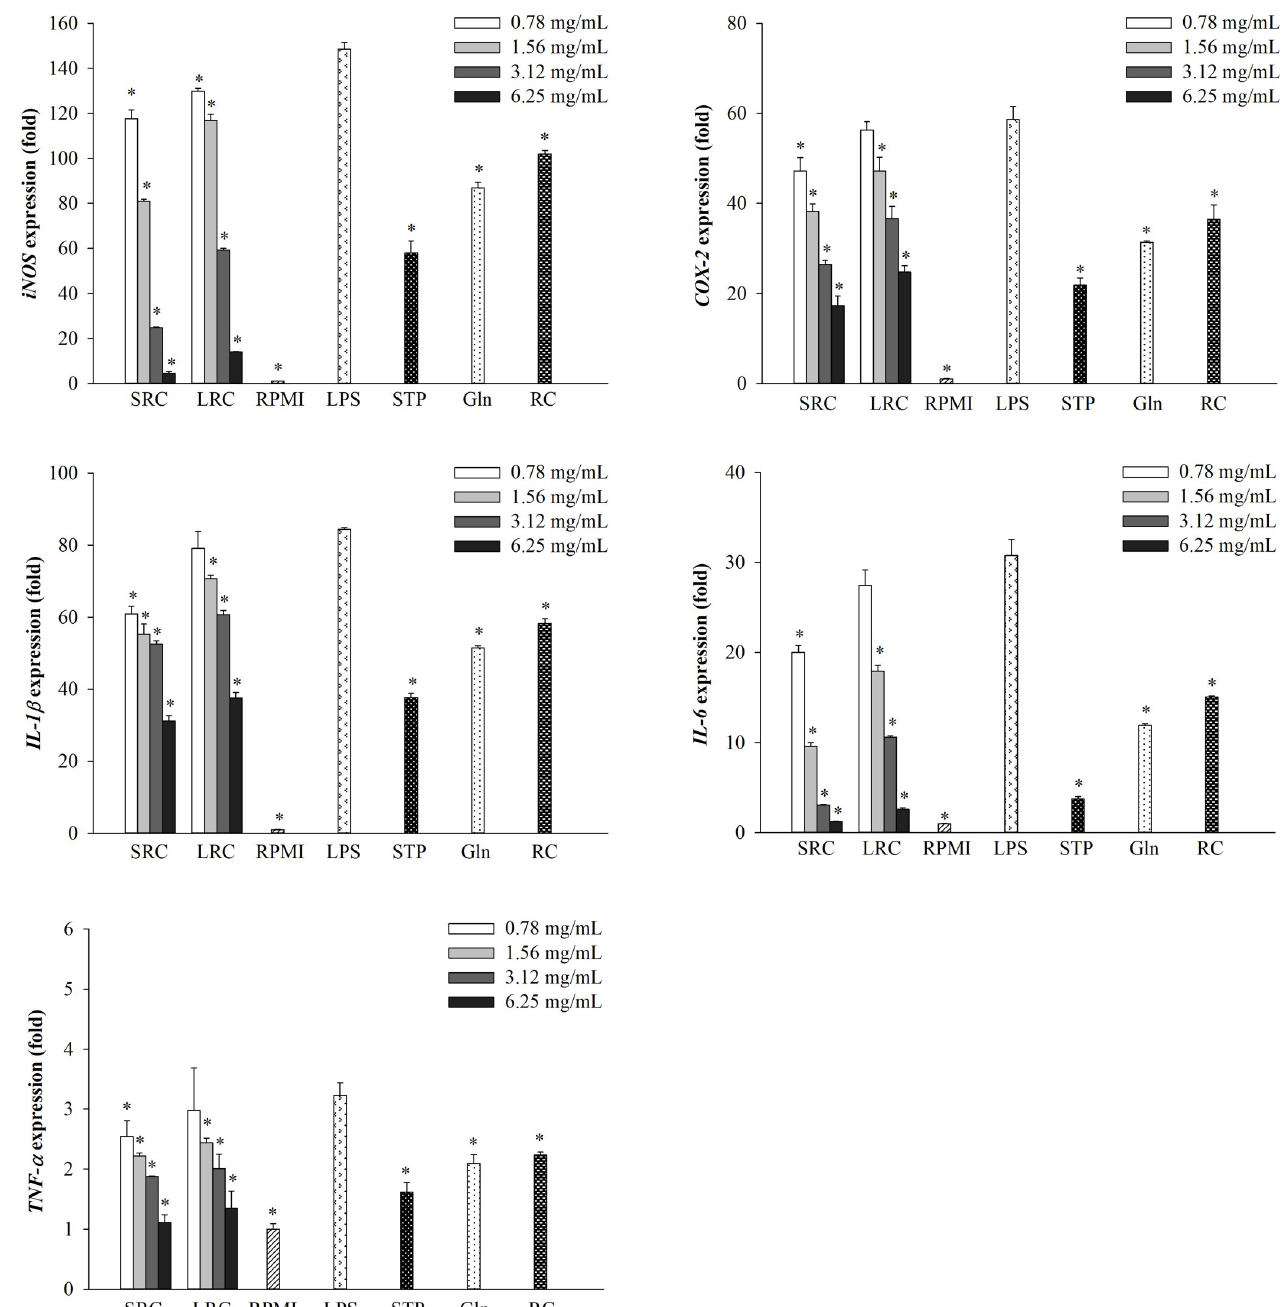
Fig 2. Effect of SRC and LRC on the mRNA expression of iNOS , COX-2 , IL-1 β , IL-6 , and TNF- α in LPS-stimulated RAW264.7 cells. The results are presented as the mean ± SD ( n = 3). Significant differences are p < 0.05 compared with LPS. SRC = strawberry rice cake, LRC = L-glutamine rice cake, STP = strawberry powder, L-glutamine = Gln, and RC = rice